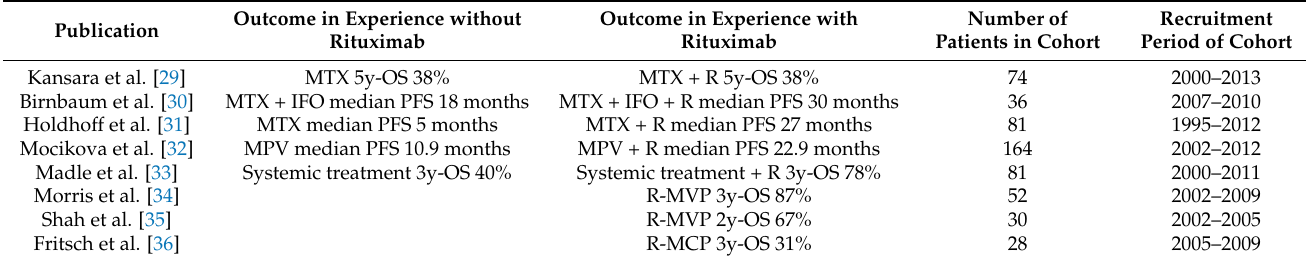
Table 2. Overview (non-exhaustive) of historical [29–33] and prospective [34–36] cohort analysis on the effect of rituximab in